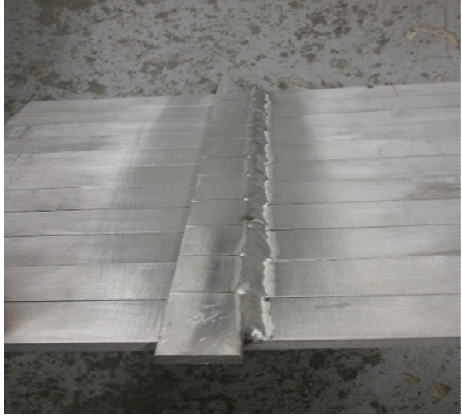
Figure 1. Pictorial view of test sample with fillet welded lap joint.